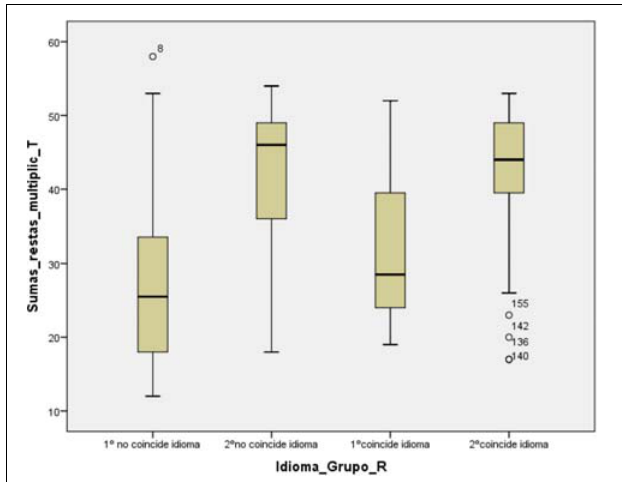
FIGURE 2 | Algorithm resolution × instruction language × grade. Source: Prepared by the authors on the basis of data.